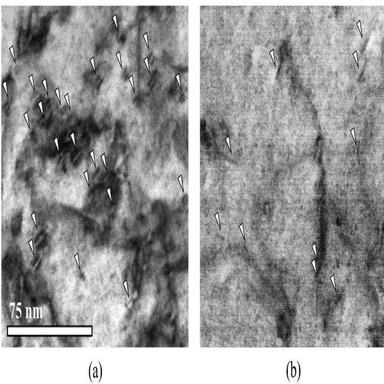
Bright-field micrographs of dislocation loops in ferritic alloys (a) T92 and (b) 14YWT after 150 dpa, dual ion irradiation. The micrographs were taken using an on-axis STEM technique adapted from Ref., with white arrows highlighting irradiation-induced dislocation loops.